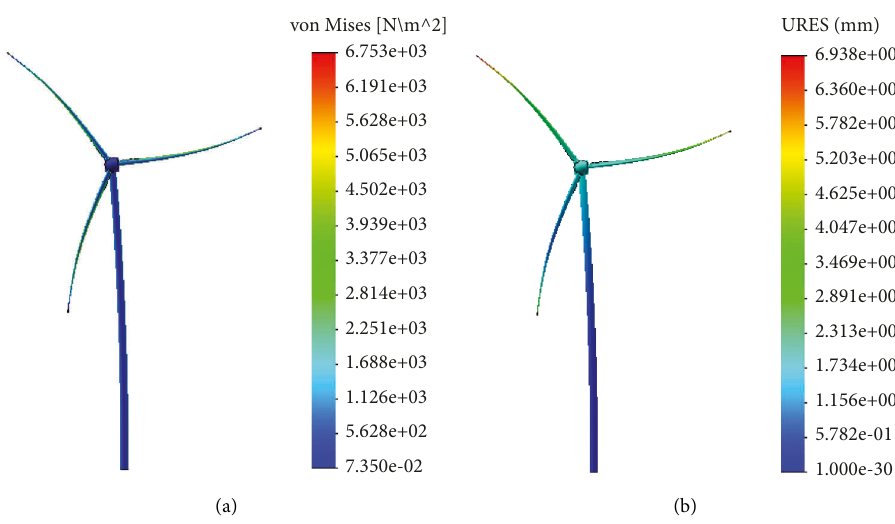
Figure 11: . Dynamic response of 9037N. (a) Stress and (b) combined